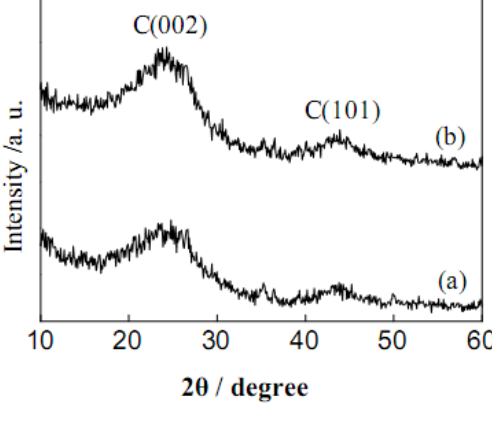
Figure 1. XRD patterns for activated carbon (a) before and (b) after sulfonation.